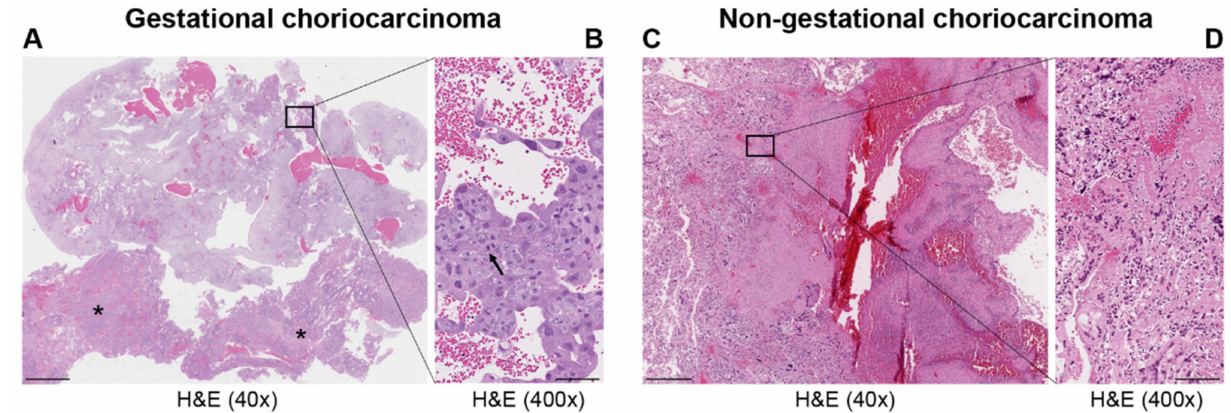
Figure 1. Representative images of hematoxylin and eosin (H&E) staining in gestational ( A , B ) and non-gestational ( C , D ) choriocarcinoma. Uterine curettage ( A , B ); ( A ) low power (40 × ; scale bar = 500 µ m) with abundant decidualized en- dometrium and blood and two large clusters of choriocarcinoma (*); ( B ) high power (400 × ; scale bar = 50 µ m) shows aggregates of large trophoblasts with marked atypia and prominent mitotic figures (arrow) covered by atypical syncy- tiotrophoblasts. Invasive choriocarcinoma in the ovary ( C , D ). ( C ) Component of a germ cell tumor of the ovary with large and atypical trophloblastic cells with hemorrhage and necrosis (low power 40 × ; scale bar = 500 µ m) associated with dysgerminoma (not present in the picture). ( D ) Markedly atypical synciotrophoblasts and cytotrophoblasts (high power 400 × ; scale bar = 50 µ